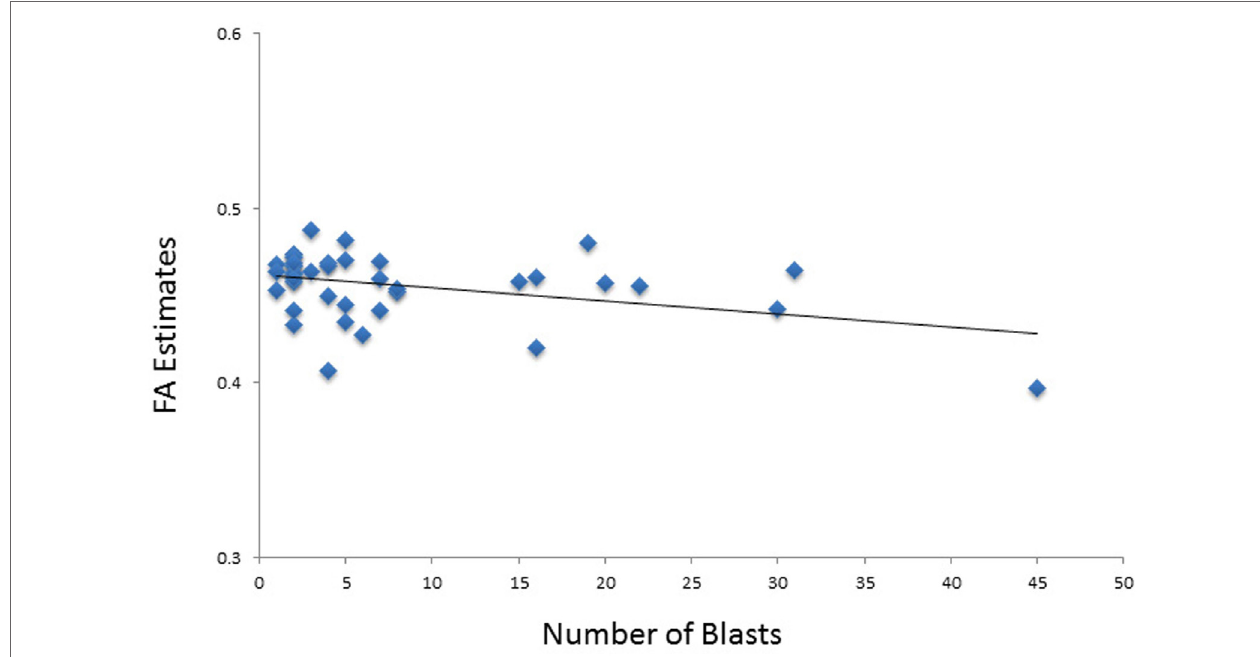
FigUre 3 | scatterplot shows the relationship between total number of blasts and fractional anisotropy (Fa) values .